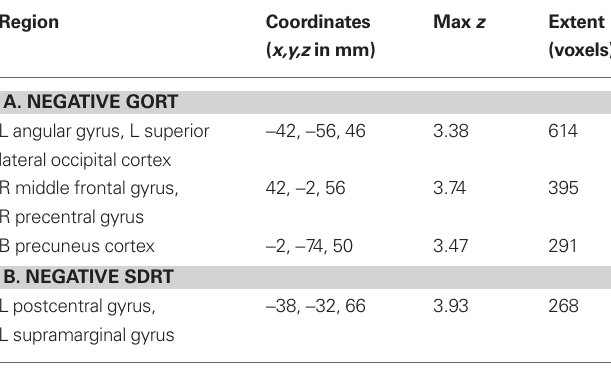
There were no significant correlations for this contrast with age or SSRT. All clusters survived whole-brain correction at z > 2.3, p < 0.05 and are reported in MNI space (mm). B, bilateral; L, left; R,